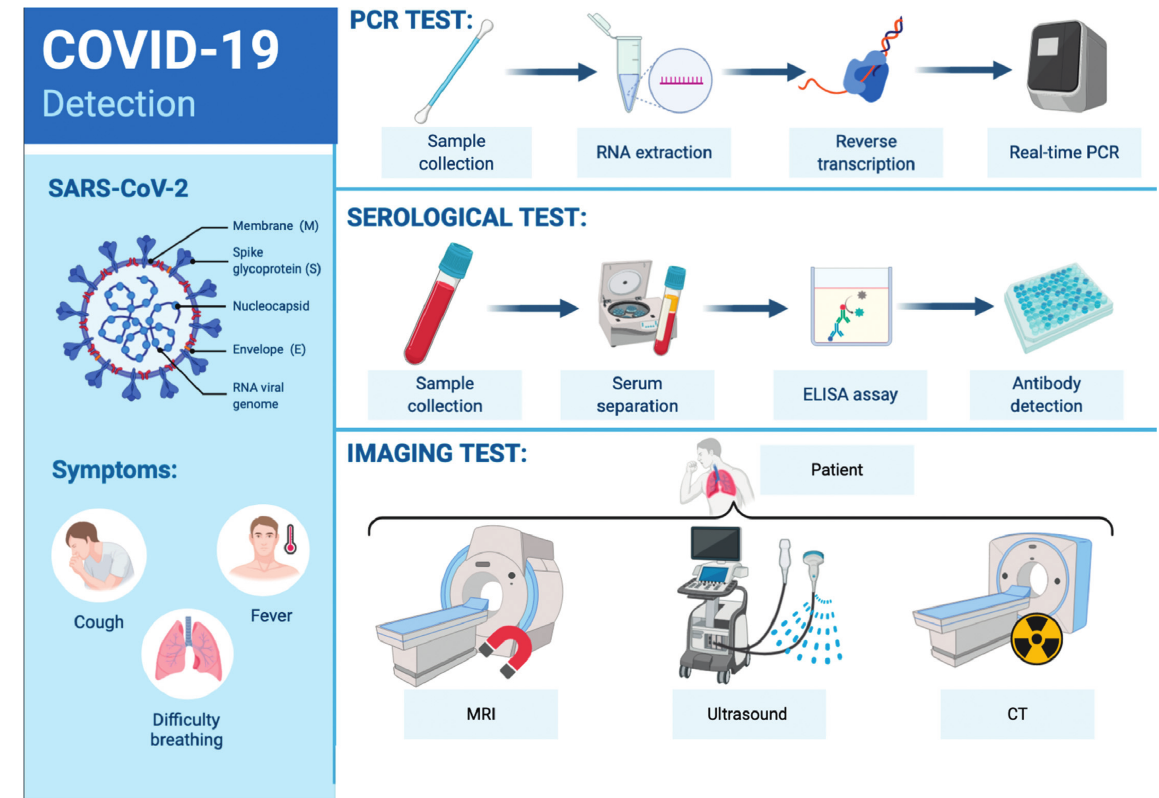
Figure 1: Summarized COVID-19 detection